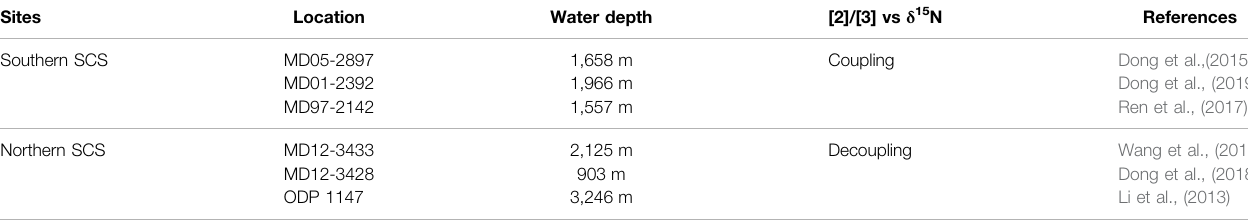
TABLE 1 | Core information and the relationship of [2]/[3] vs. δ 15 N in the southern and northern SCS.